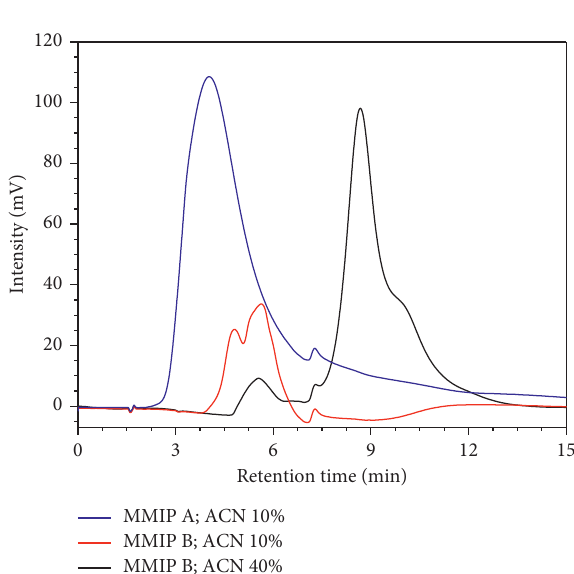
Figure 7: The effect of different crosslinkers employed in the separation of rac -citronellal. The isocratic elution using ACN/water as the mobile phase with a flow rate of 0.04mL/min was